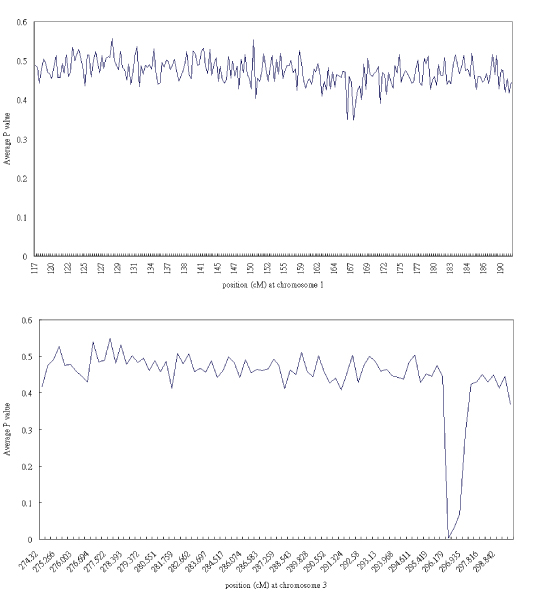
Average p-value of 100 replicates for each SNP on chromosome 1 (A) and chromosome 3 (B).